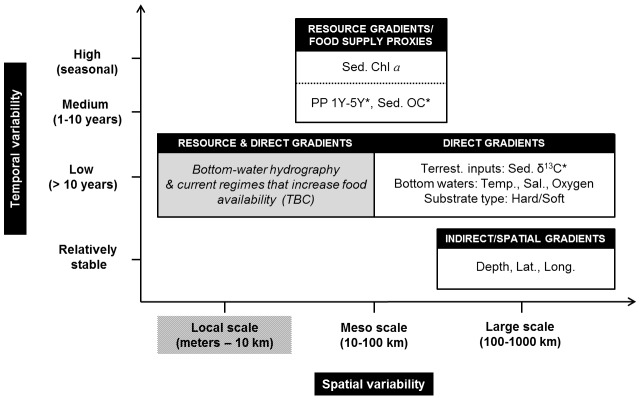
Conceptual figure displaying the overall results of environmental drivers of megabenthic communities in this study in relation to their spatial and temporal scales of variability; potential missing important drivers (gray box) would have to be confirmed (TBC).Environmental factors available for the present study were divided into three categories: resource, direct and indirect/spatial gradients (following [14]). Sampling design of the present study prevented conclusion at local scale (dashed). * denotes environmental variables that were either significantly correlated with univariate community characteristics or to community cluster distribution.